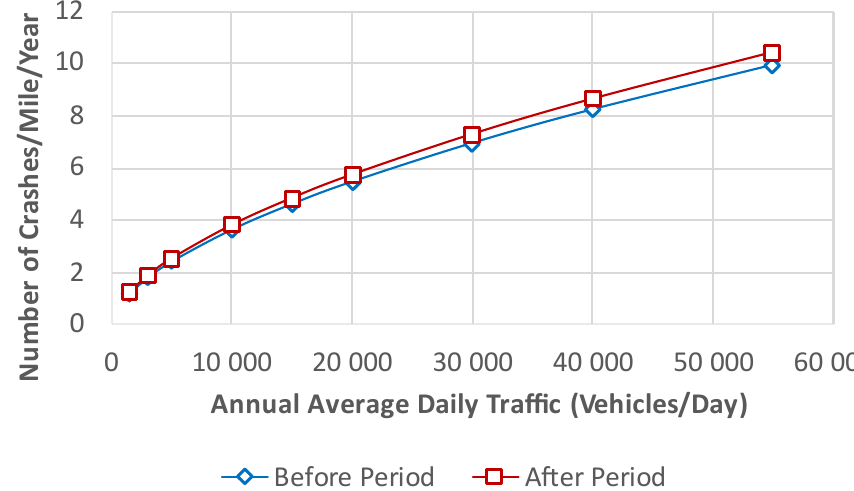
Figure 1 Annual number of crashes for increase site based on study period and AADT